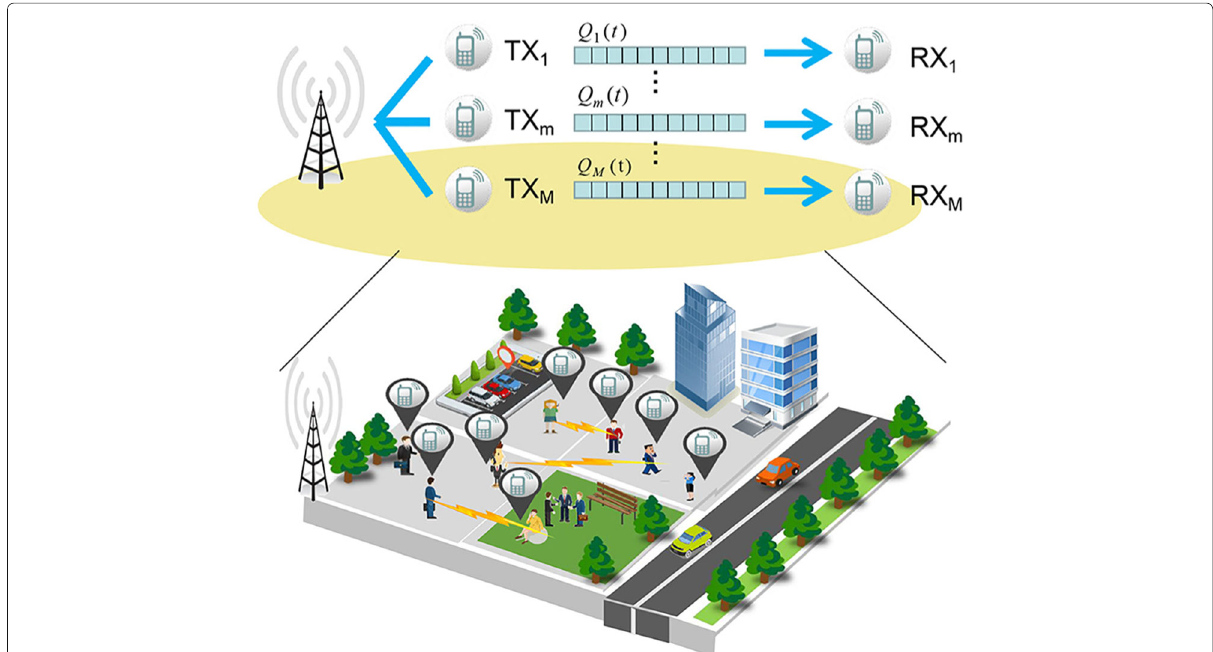
Fig. 1 The D2D-based relay